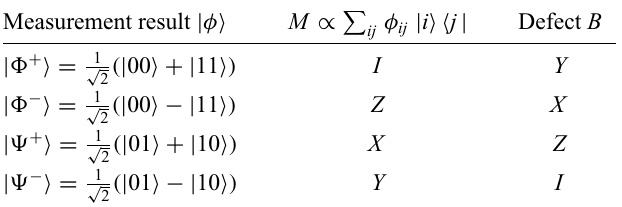
TABLE I. The possible measurement results and the corre- sponding matrix M inserted into the MPS. In each case, M ∝ SB , where S is the desired singlet matrix and B is a residual Pauli defect. Global phases are ignored in defining M and B